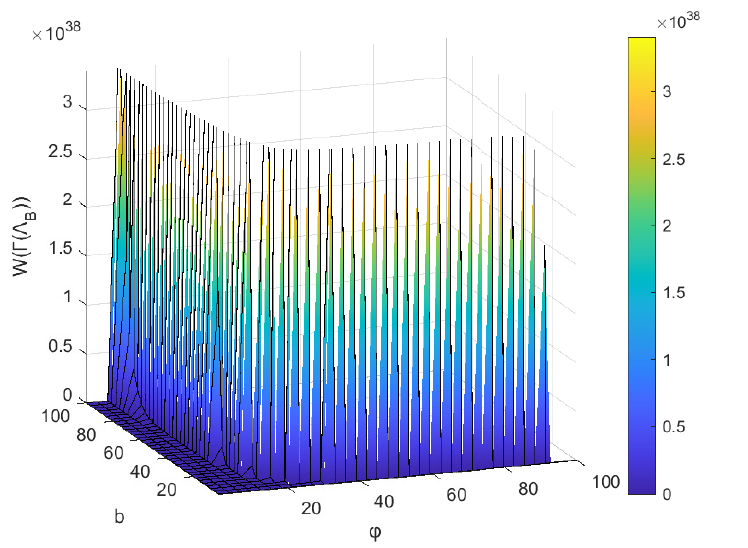
Figure 1. Wiener index of Γ ( Λ (cid:66) )